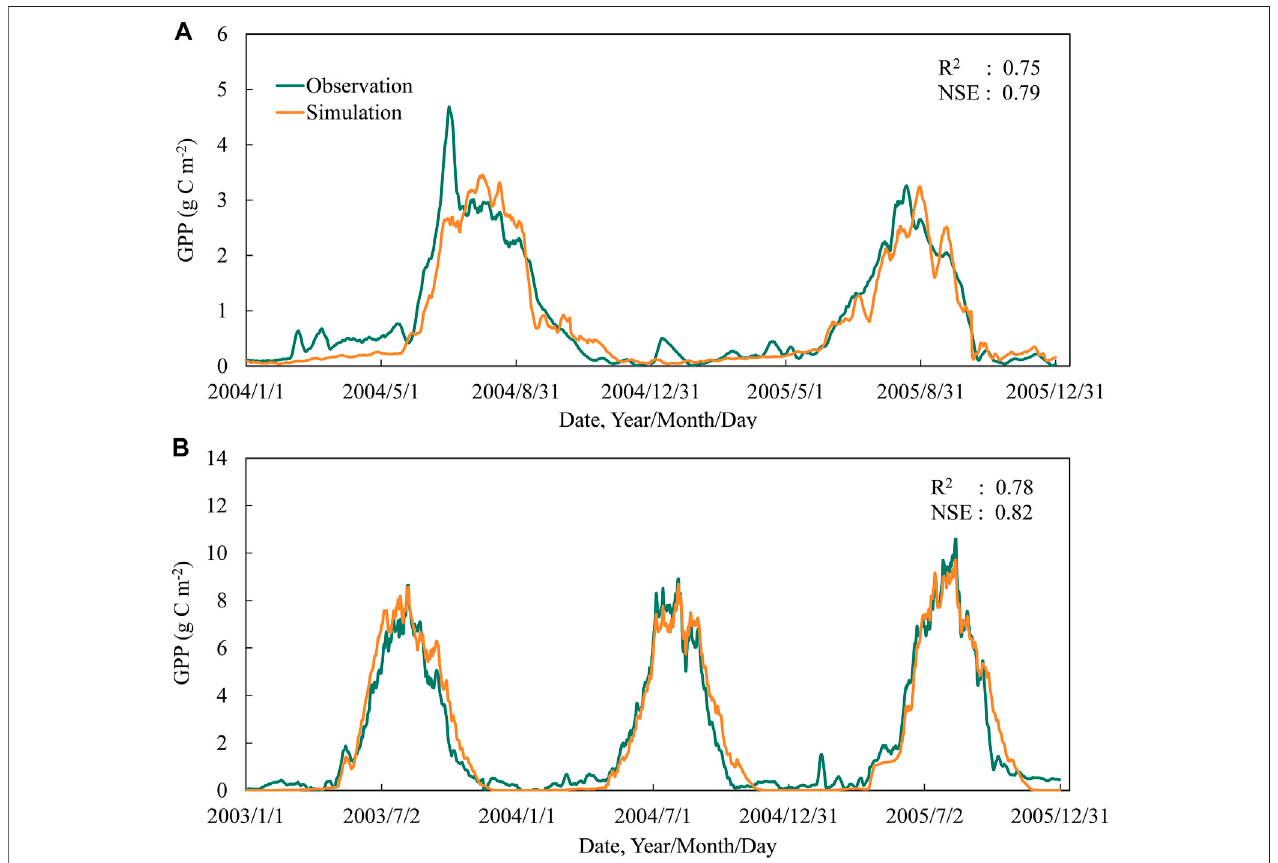
FIGURE 4 | Simulated and observed gross primary product (GPP) values at Damxung (A) and Haibei (B) sites.